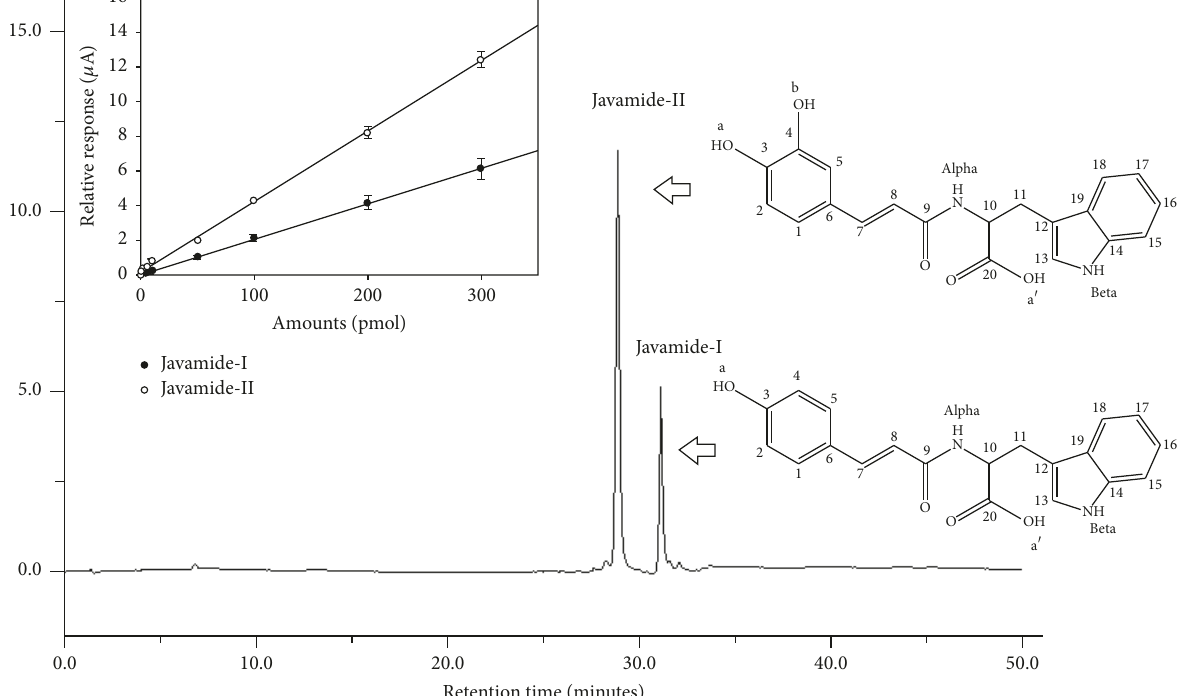
Figure 1: HPLC chromatograms and chemical structures of javamide-I/javamide-II. HPLC analysis was performed and the standard curve (insert; 𝑓(𝑥) = 0.0204 ; 𝑅 2 = 0.99 for javamide-I and 𝑓(𝑥) = 0.0414 ; 𝑅 2 = 0.99 for javamide-II) was produced, described in Materials and Methods. The peaks of the standards ( 𝑛 = 5 ) were detected using an electrochemical detector.